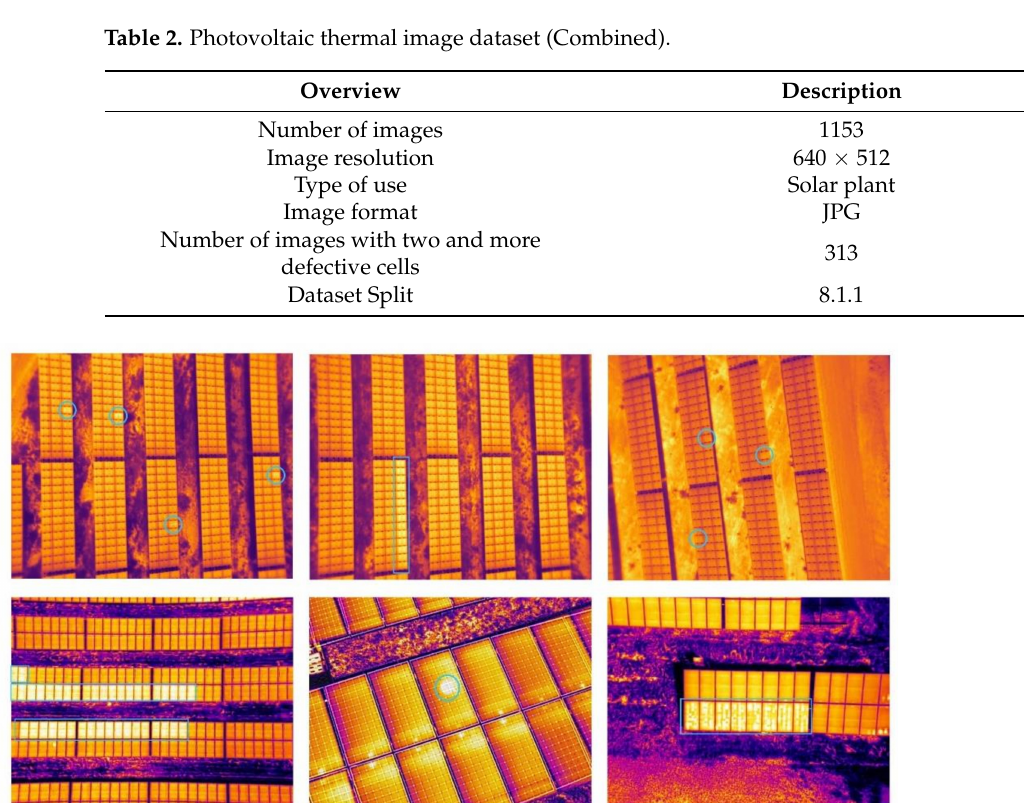
Figure 1. Examples of raw images of both datasets, the blue circles and squares show the defective cells on the image. The thermal camera attached to the drone located the issue during a maintenance inspection. Sample images of thermal image dataset. ( a ) Photovoltaic thermal image dataset (existing); ( b ) our dataset (newly